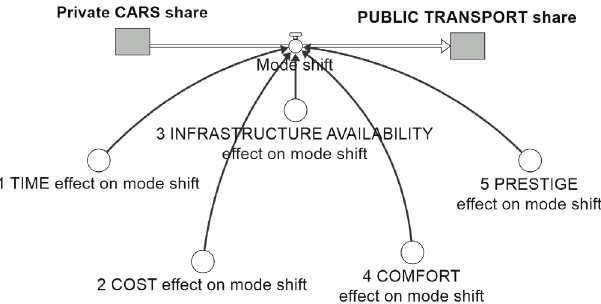
Fig. 3. Factors influencing mode shift included in the system dynamics